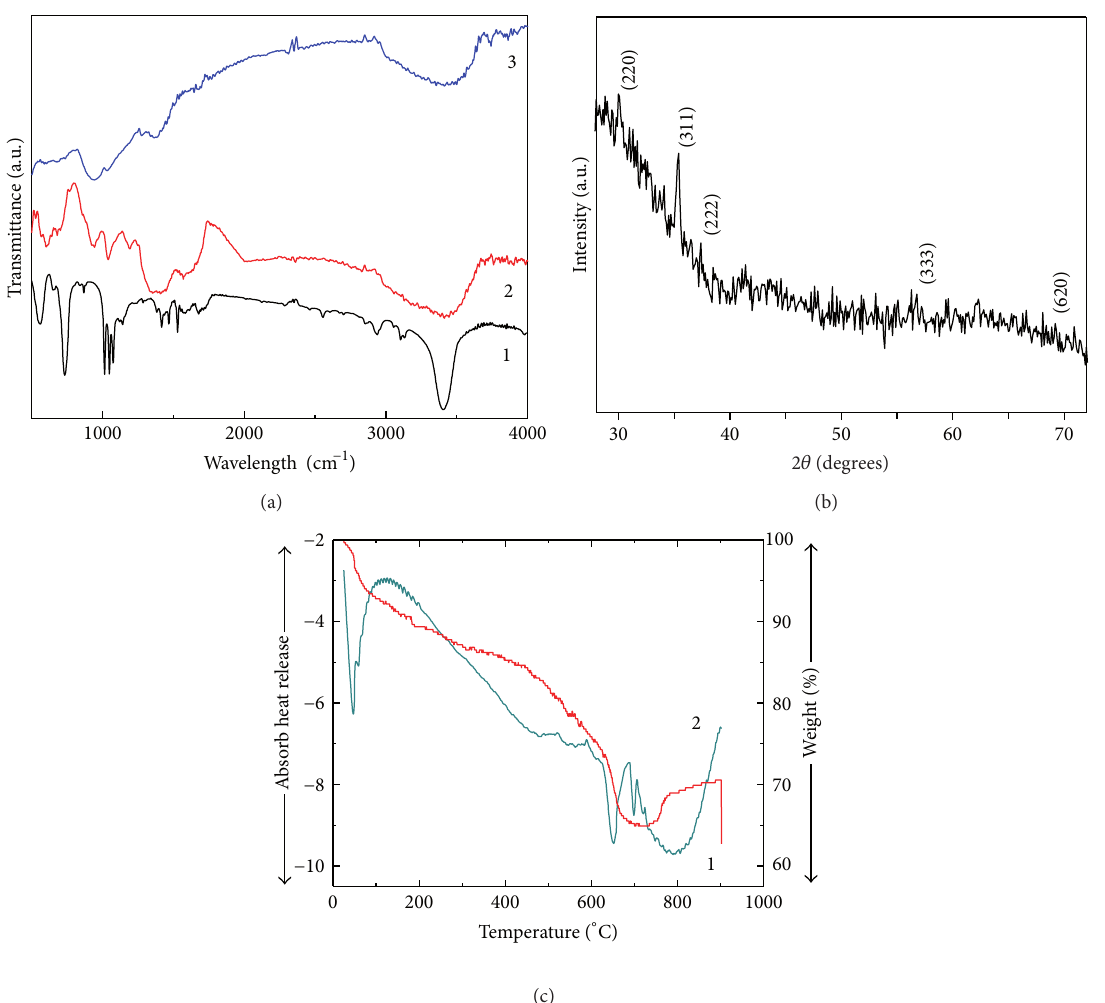
F 3: In (a) are represented FTIR spectra of cationic surfactant pyrrole (spectrum 1), as-prepared Fe O particles aer thermal analysis (spectrum 3); (b) XRD of Fe Fe (1) differential thermogram analysis (2) patterns of Fe 3 4